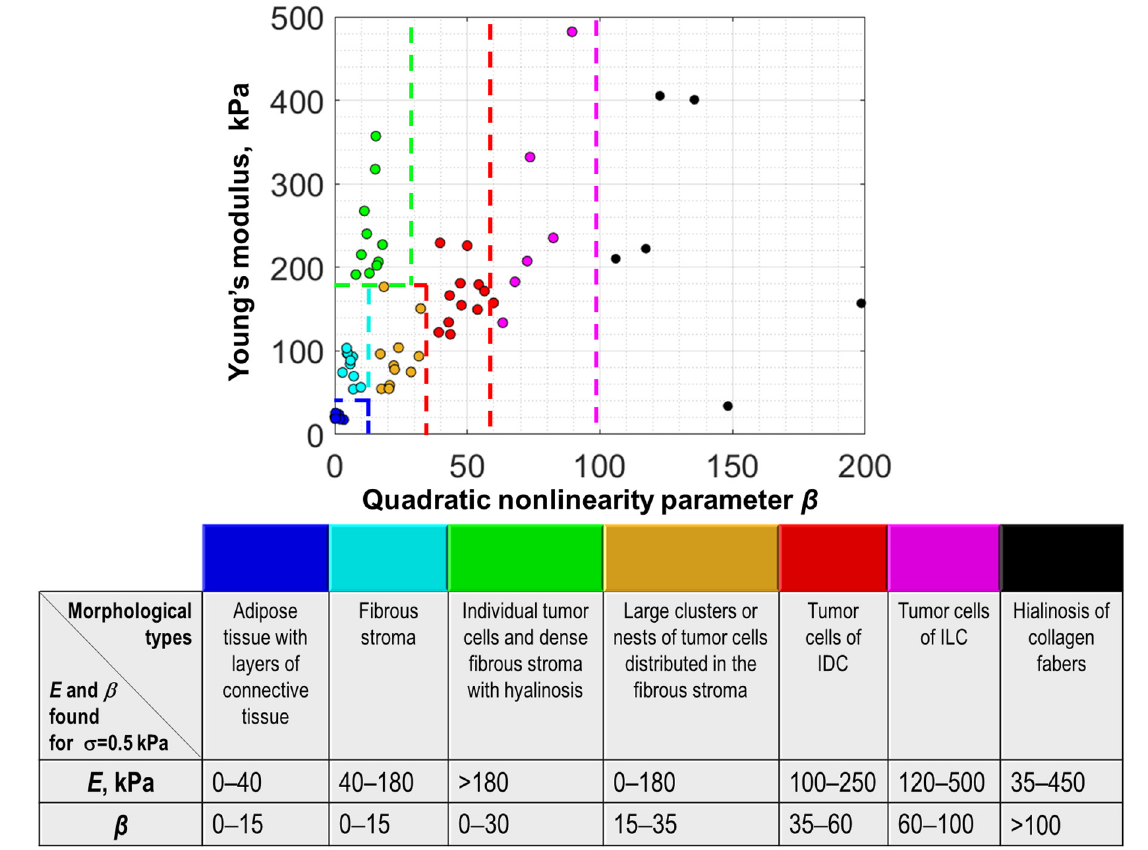
Figure 5. Two-dimensional plane ( E , β ) of the Young’s modulus and nonlinearity parameter for the same seven histologically different tissue types as in Figure 3 obtained using 60 samples taken from 50 patients. Notice that malignant tissues (green, orange, red, and magenta points) tend to exhibit stronger nonlinearity than benign tissues (blue and light-blue points); the strongest nonlinearity is typical of hyalinosis. Although the Young’s modulus of adipose is clearly the lowest, for the other tissue types, the dependence of the Young’s modulus on the malignancy degree is not that clear and strong overlap of stiffness ranges may occur. (Abbreviations: IDC—invasive ductal carcinoma; ILC—invasive lobular carcinoma).